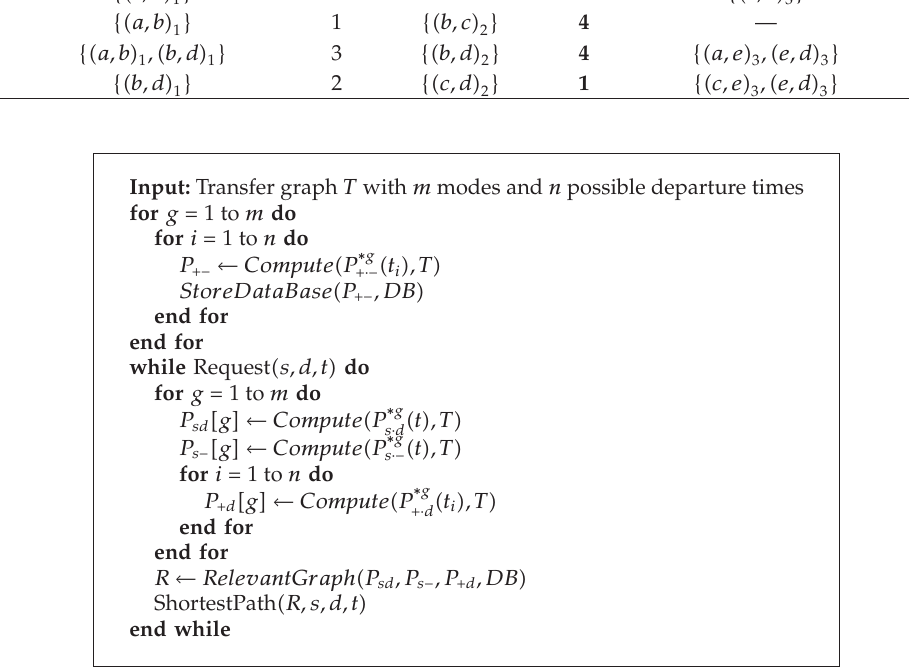
Algorithm 1: Transfer graph